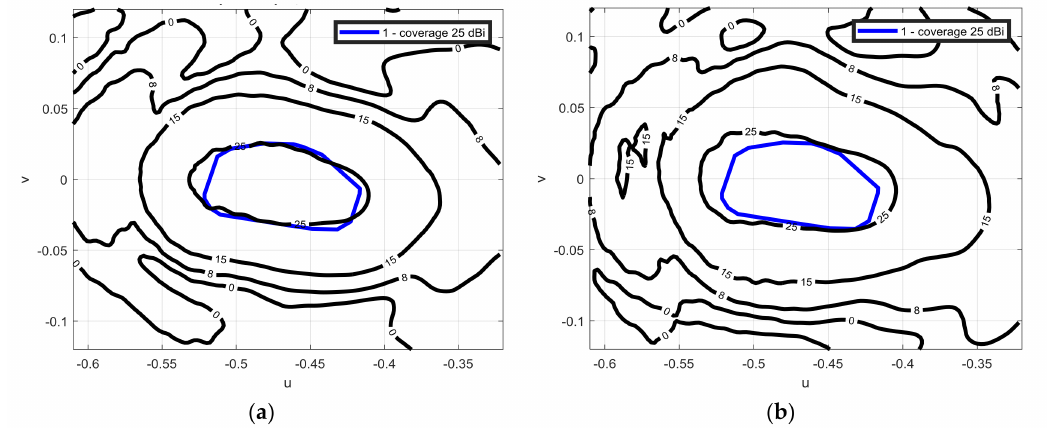
Figure 7. Measured contoured patterns in dBi (solid black line) superimposed to the coverage mask (thicker solid blue line) for vertical polarizations: ( a ) at 12.975 GHz; ( b ) at 14.25 GHz.